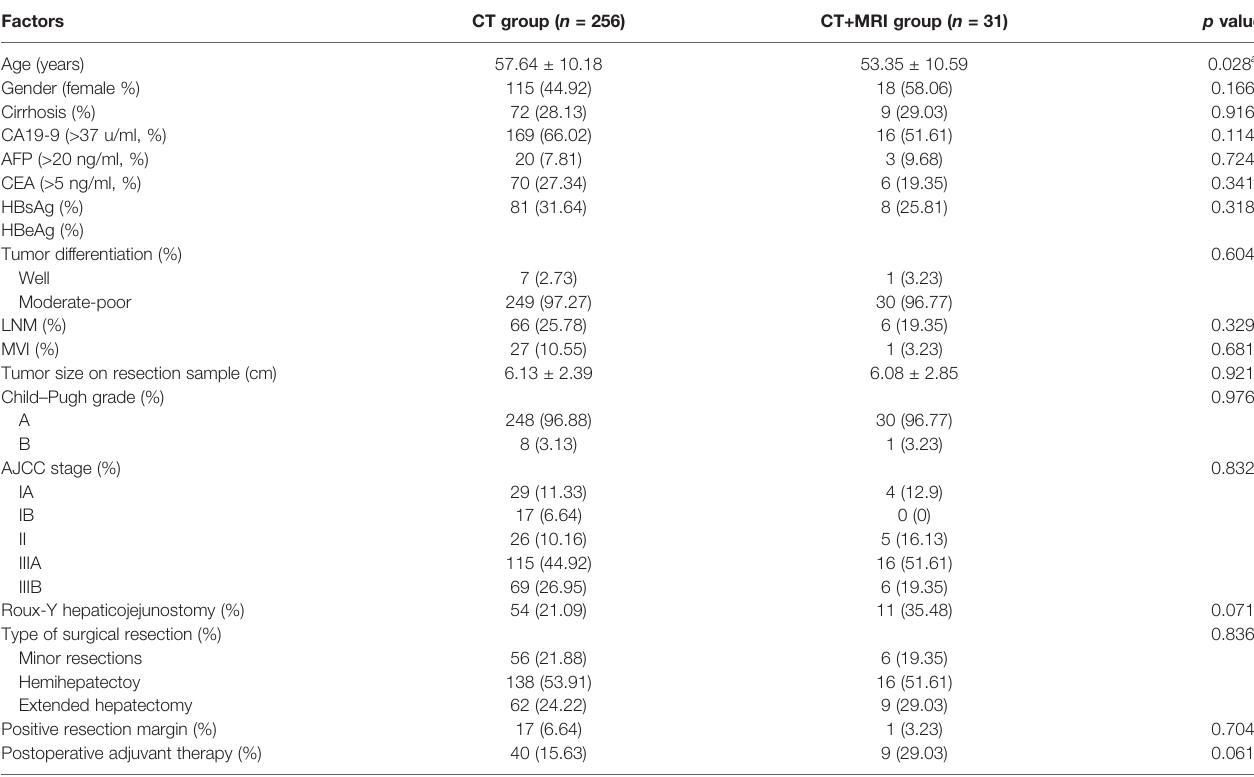
TABLE 1 | Demographic and clinical characteristics of the ICC patients.